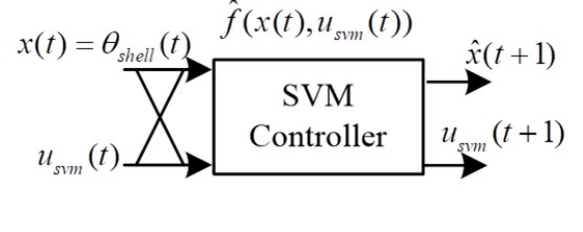
Fig. 3 The SVM learning control